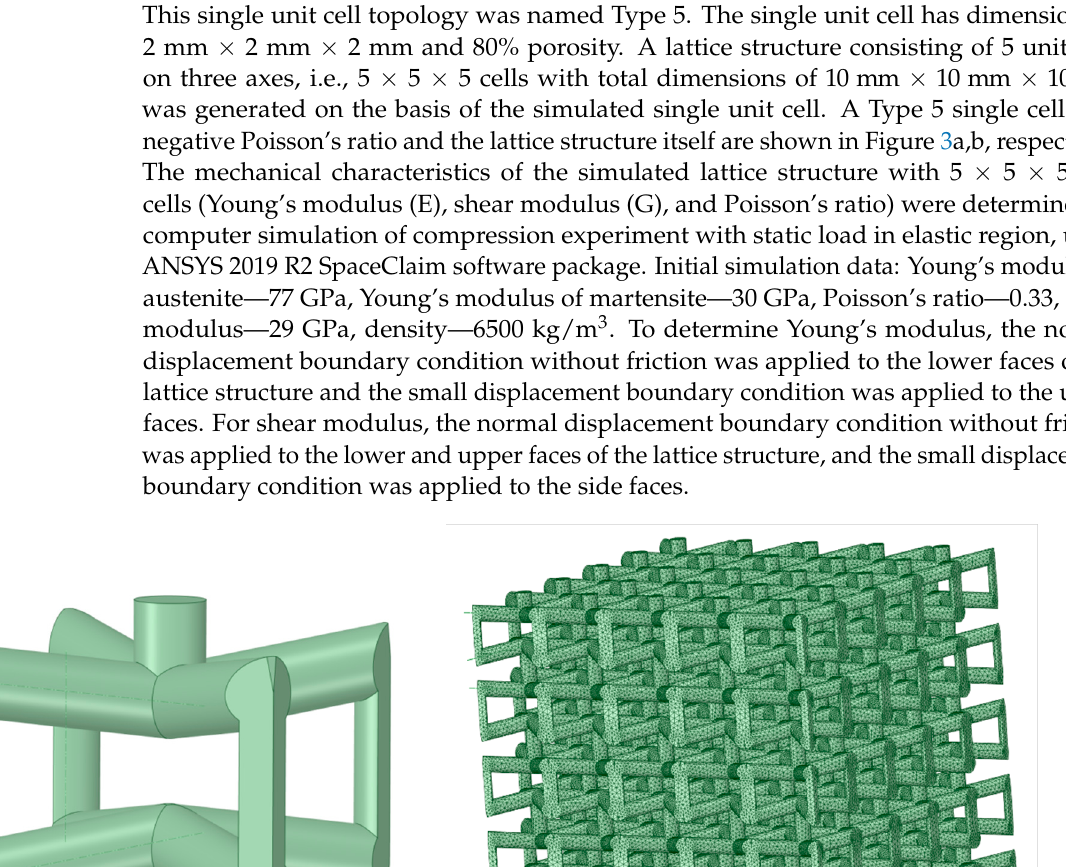
Figure 2. ( a ) SEM image of initial powder; ( b ) Initial powder particle size.